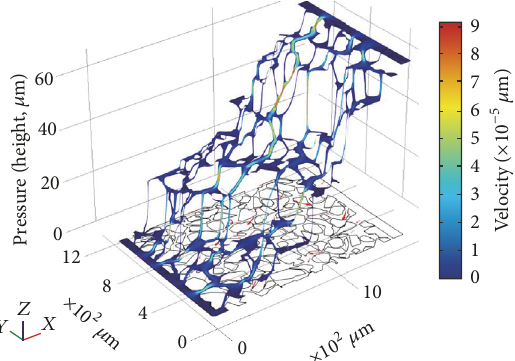
Figure 9: Simulation results of pore pressure decline of Sample